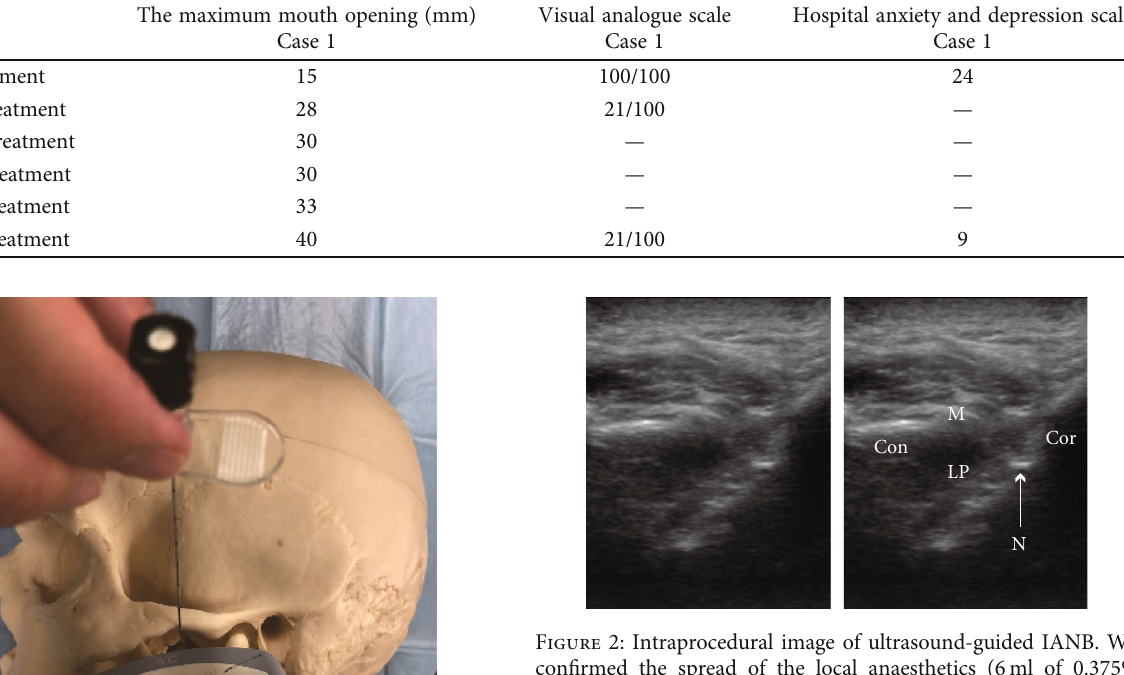
Table 1: Changes in the maximum mouth opening, visual analogue scale, and hospital anxiety and depression scale scores.